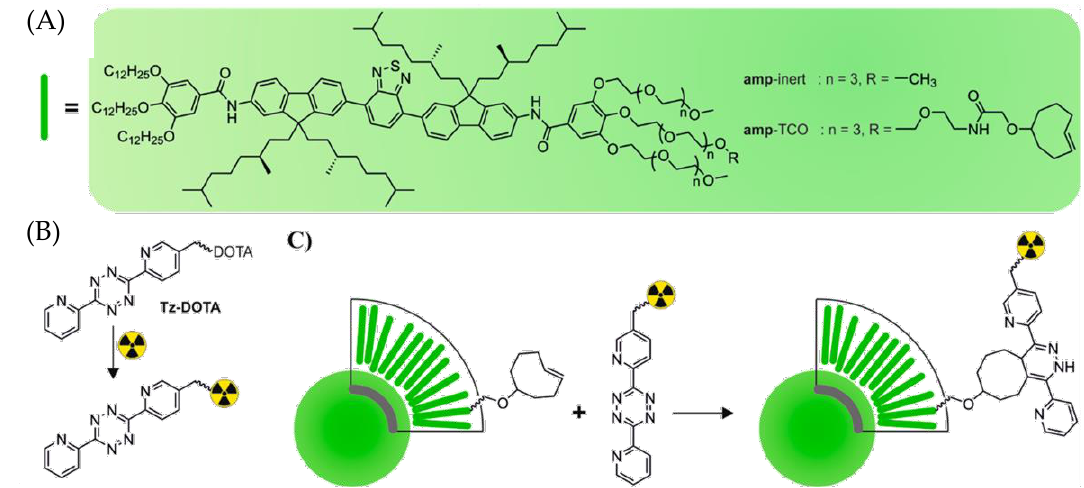
Figure 6. ( A ) Chemical structures of the amp-inert and amp-TCO [102], which self-assemble into SMNPs. ( B ) Two-step radiolabeling strategy by chelation of the radionuclide by Tz-DOTA followed by ( C ) conjugation of labeled Tz-DOTA to amp-TCO [101].